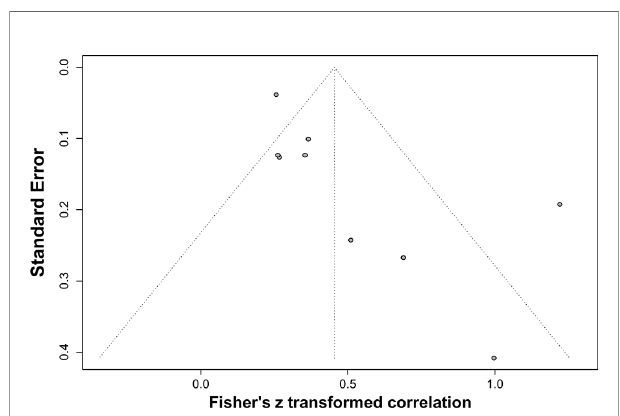
FIGURE 8 | Funnel plot shows publication bias of the identi fi ed surveys to investigate the correlation between HIV-1-speci fi c antibody titer and HIV-1